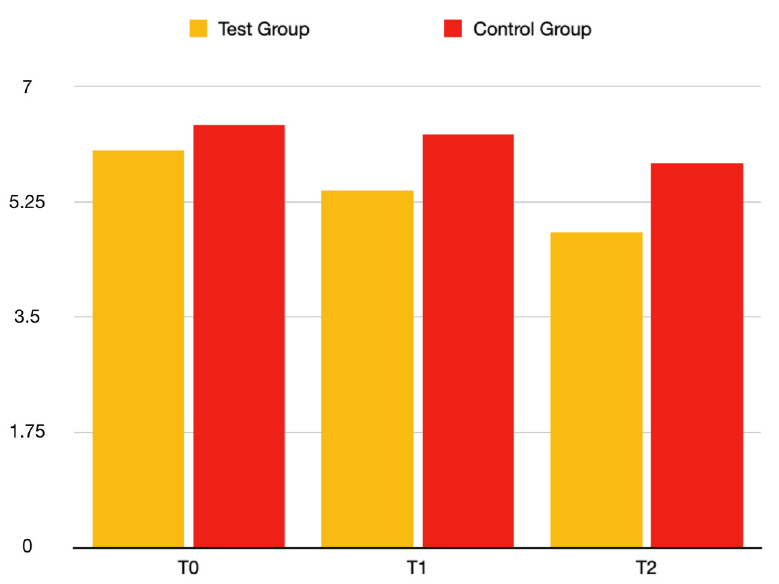
Figure 4. Graphic reporting the mean dimension of the lesion in the test group and control group at T0, T1, and T2. Table 4. VAS and dimension of the lesion at 3 days (T1) and 5 days